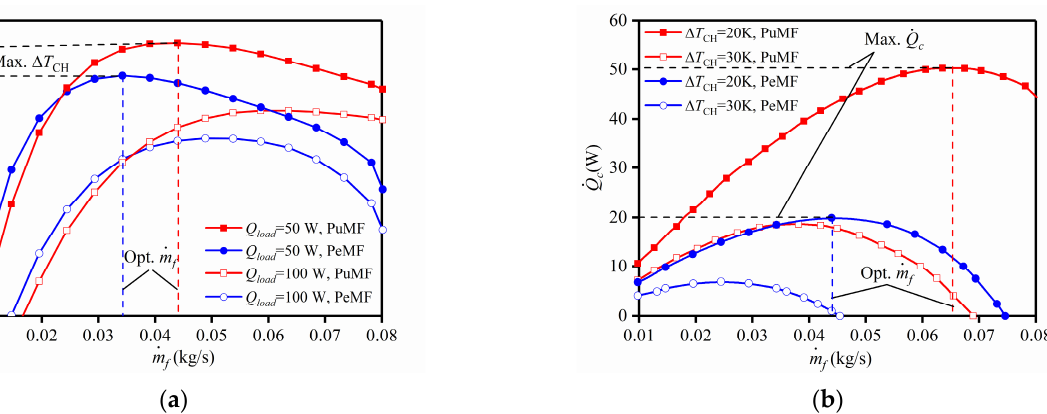
. under different 𝑚(cid:4662) (cid:3033) ( H